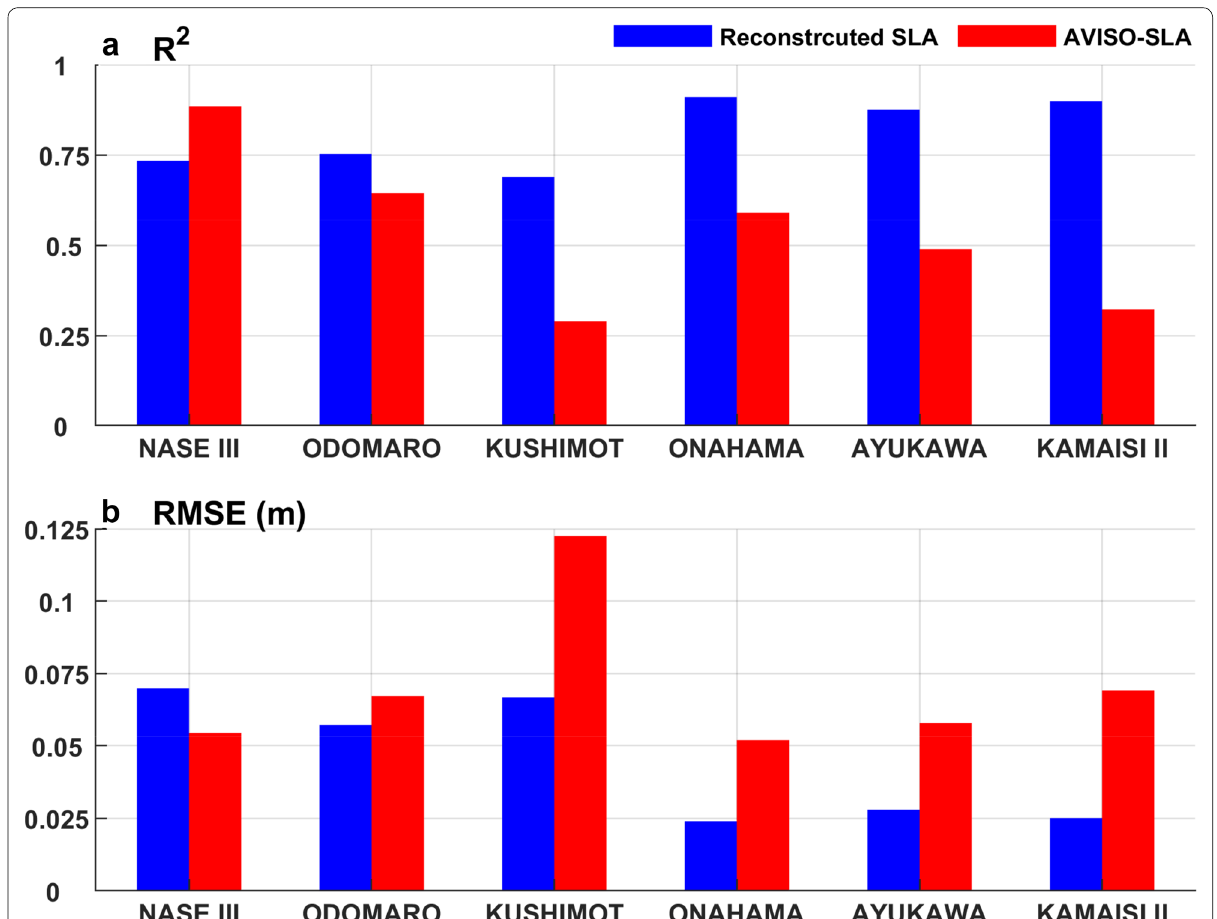
Fig. 7 The correlation coefficients ( R 2 ) and root mean square errors (RMSE) of reconstructed SLA and AVISO SLA compared with the observed SLA at the six tide gauges (blue stars in Fig.